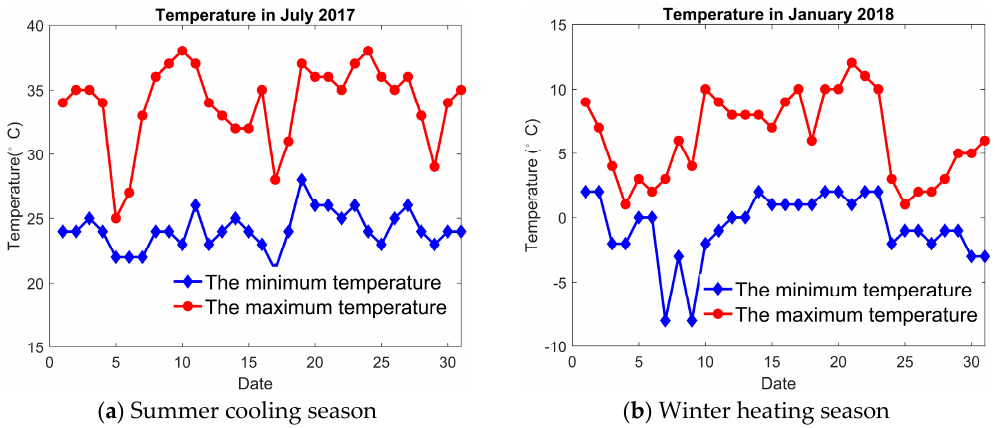
Figure 2. The temperature variation of Hanzhong city.